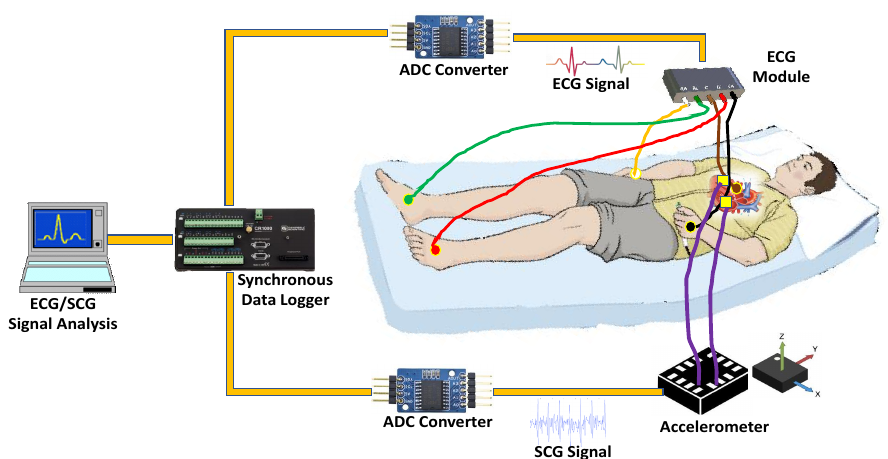
Figure 5. Architecture of ECG/SCG data collection